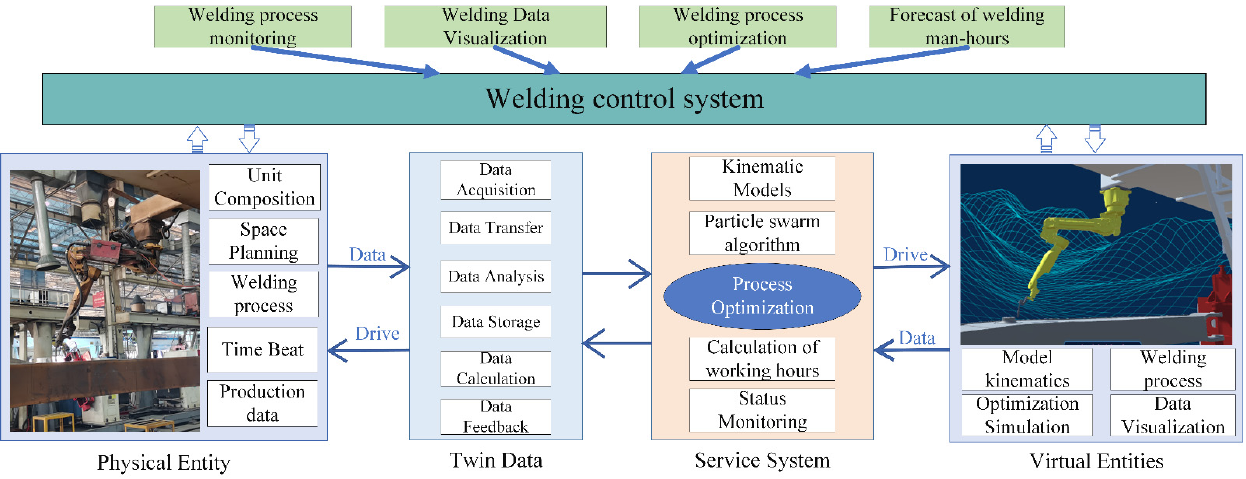
Figure 3. Block diagram of digital twin welding workstation.